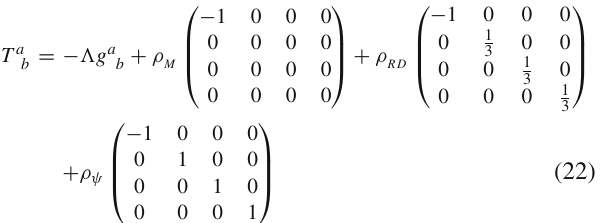
setting the current value of (cid:5) ψ as 0 , 10 − 19 , 10 − 16 and 10 − 13 . They are plotted as a black-long-dashed curve, a red-solid curve, a green-short- dashed curve and a blue dotted curve,